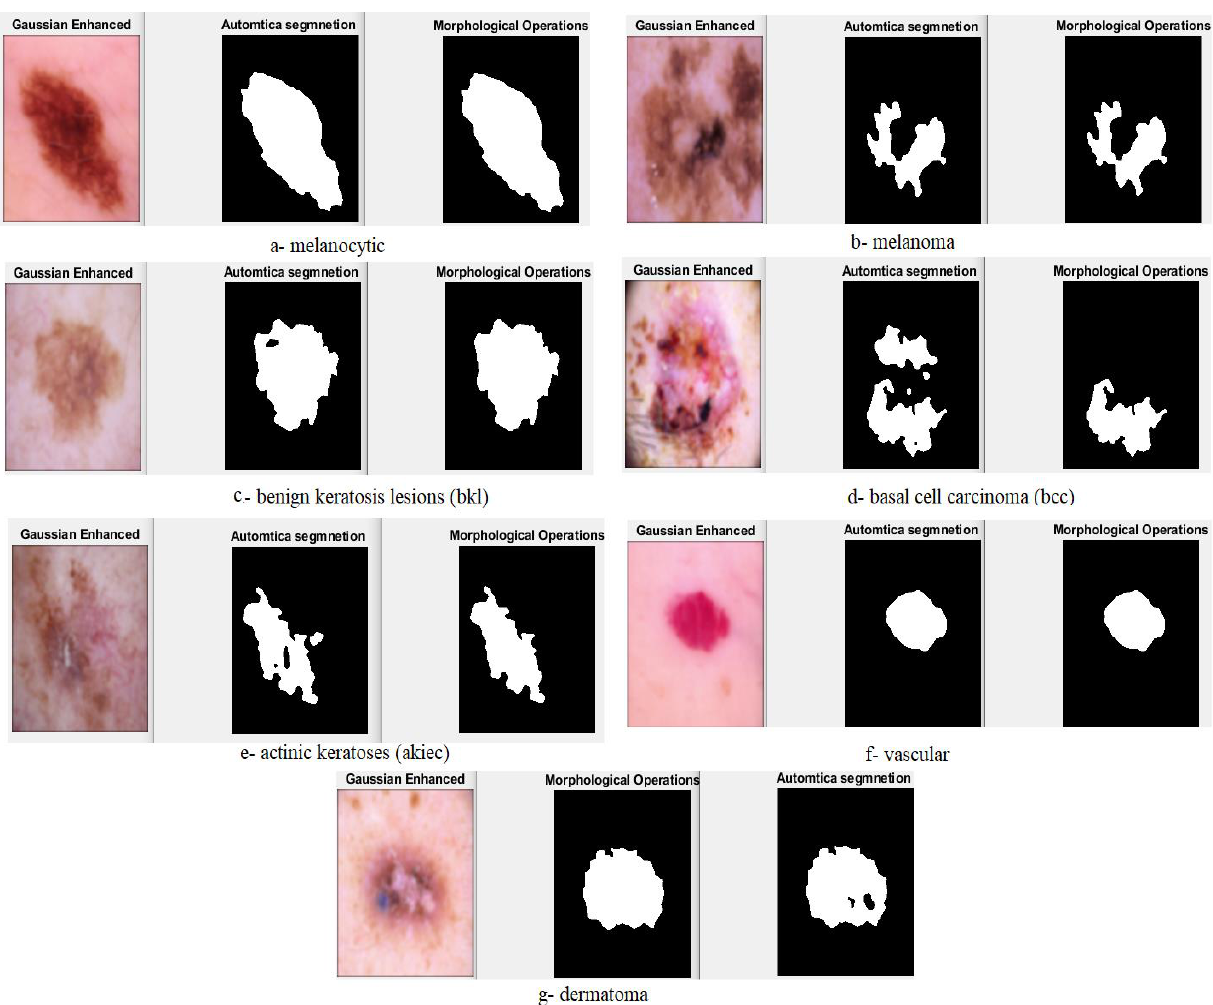
Figure 5. Enhancement and segmentation process for some images from the ISIC 2018 dataset.